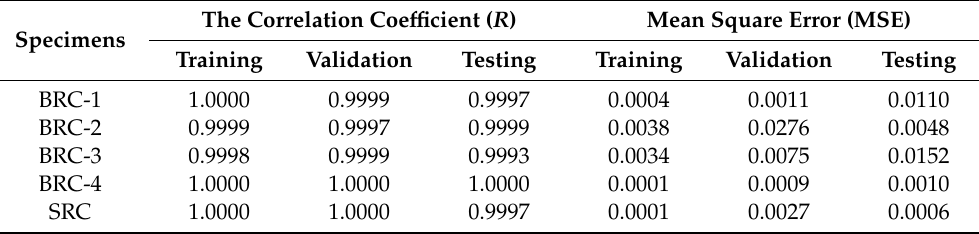
Figure 12. Prediction of the load vs. displacement relationship using ANN and using experimental observation for the training, validation, testing, and all datasets (SRC). Table 6. The validation results of the relationship load vs. displacement using the ANN